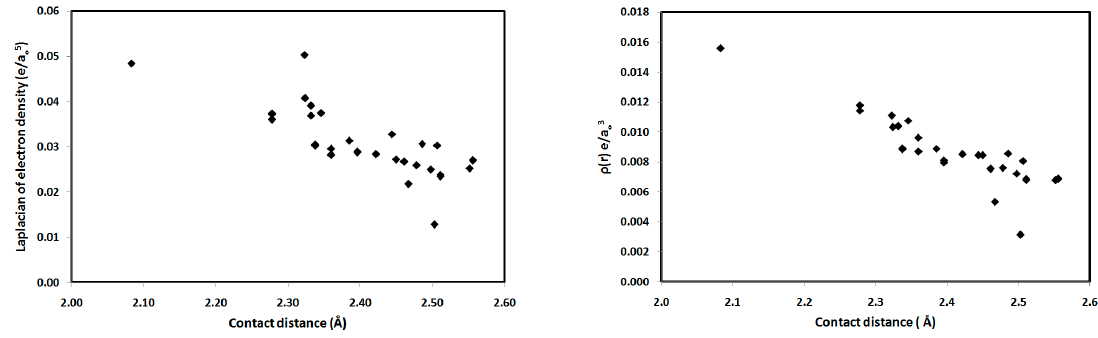
Figure 10. Contact distances versus the topological parameters ∇ 2 ρ (r) and ρ (r) for the studied systems.